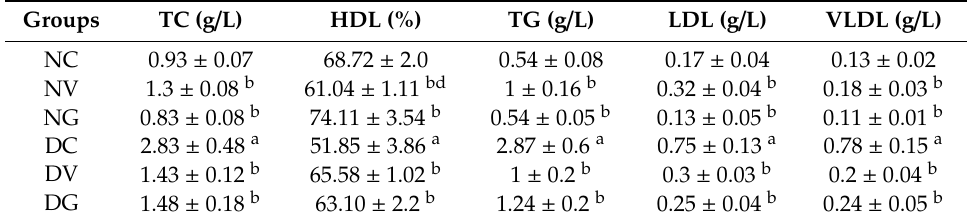
Table 3. Serum lipid profile for type 2 diabetes mellitus (T2DM)-induced rats after 6 weeks treatment with